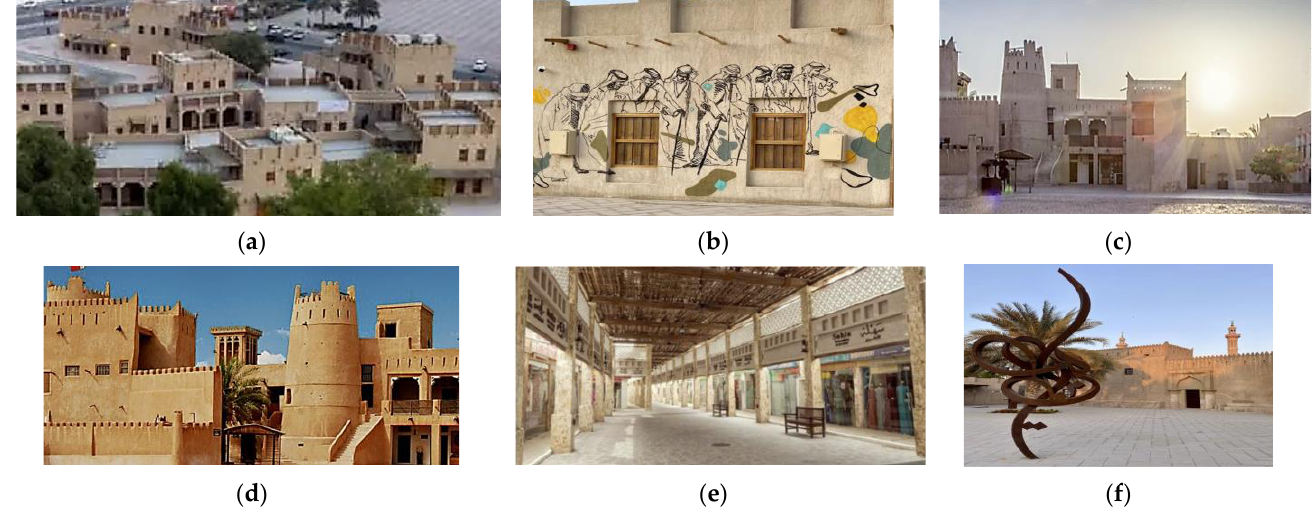
Figure 4. The Ajman Heritage area [44] ( a ) Heritage area; ( b ) Art street; ( c ) AL-MURABBAA watch- tower; ( d ) Ajman Museum; ( e ) Souq Saleh; ( f ) AL MIZAN sculpture.